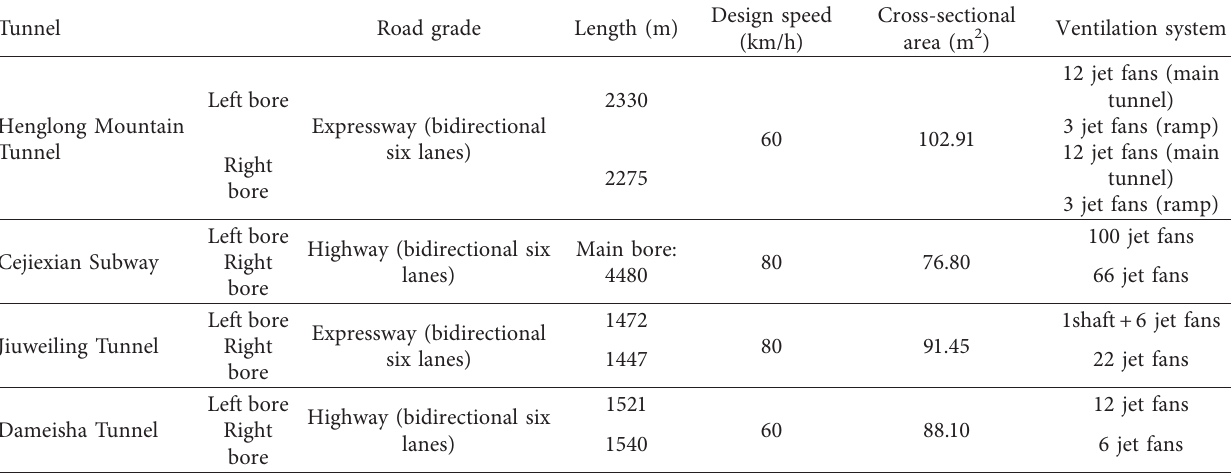
Table 4: The general parameters of the four